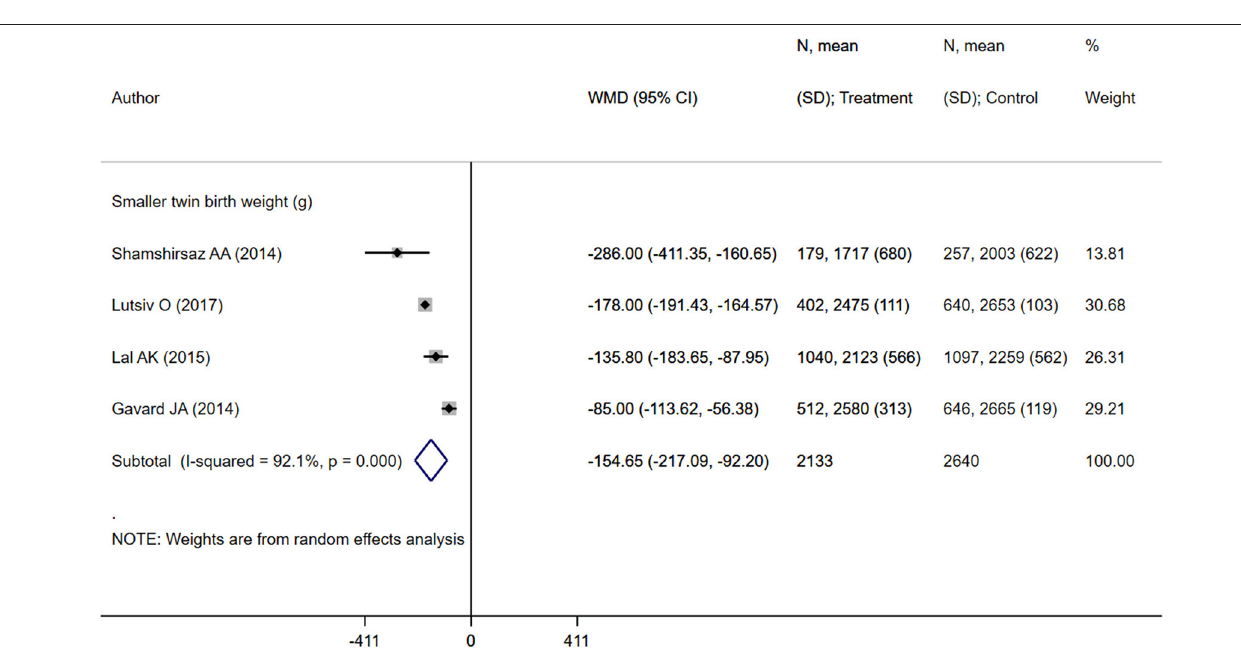
Overweight Mothers (Pre-pregnancy BMI: 25–29.9 KG/M 2 ) Maternal inadequate or low gestational weight gain, compared to adequate weight gain, was associated with an increased risk of small for gestational age status (OR 1.47; 95% CI: 1.04,